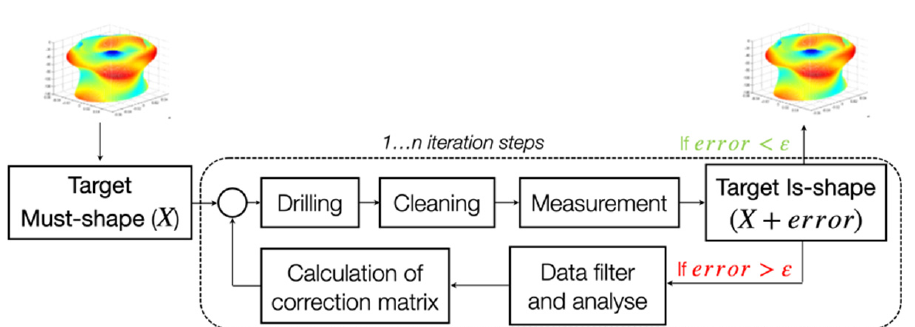
Figure 3. Iterative process: Schematic representation of the iterative incorporation process as a “manual control loop” [1].